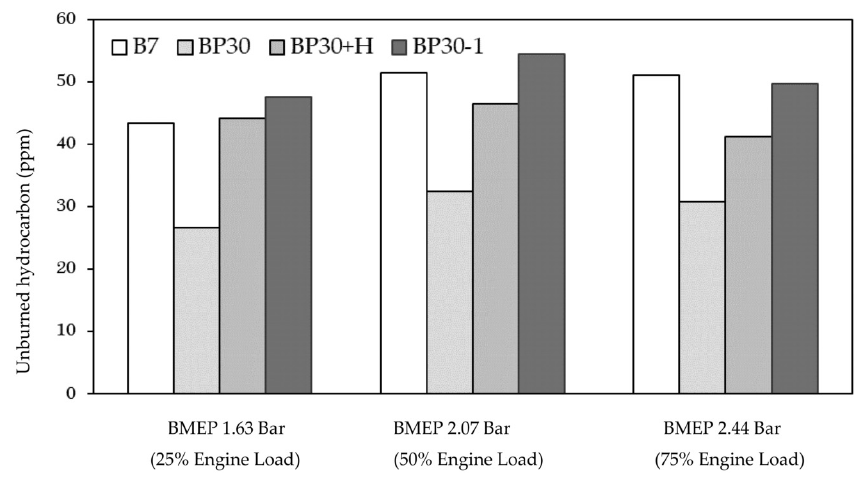
Figure 13. Effects of fuel enhancement on unburned hydrocarbon.